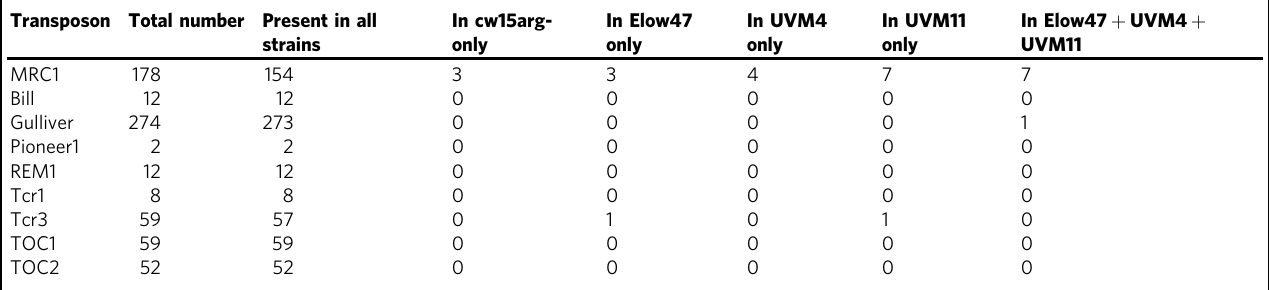
Table 2 Presence of transposons in the wild-type strain cw15arg-, the wild type-like strain Elow47 and the srta mutant strains UVM4 and UVM11 as determined by whole-genome sequencing (cf. Supplementary Data 8).